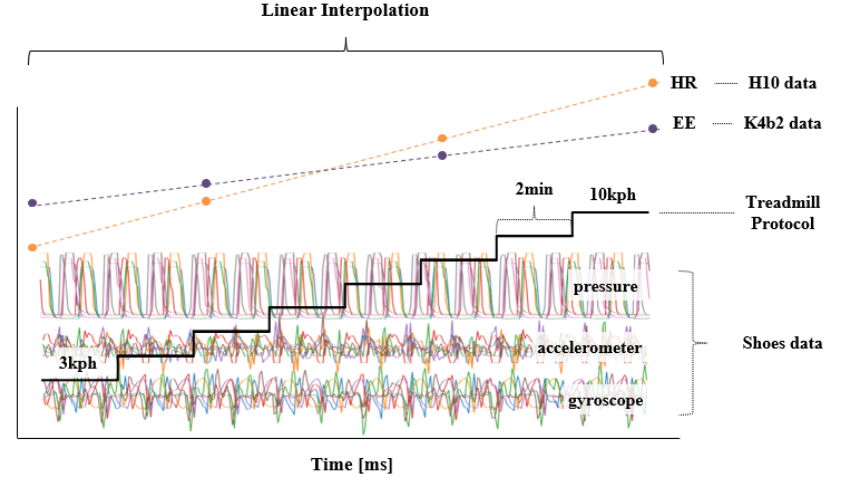
Figure 5. Application of a linear interpolation method due to the mismatch between the sampling rates of the HR/EE and data of the shoes’ sensors. In the HR and EE graphs, the green dot represents HR and the gold dot represents the EE of the actual measurement, and the dashed line is the estimated